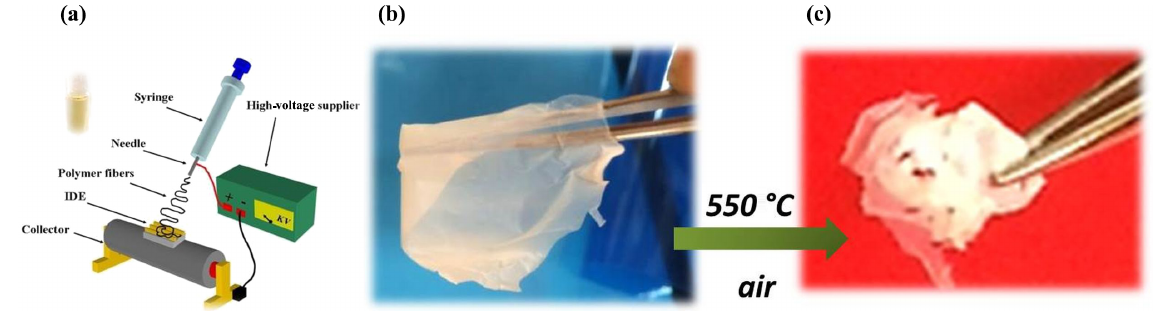
Figure 1. A sketch of an electrospinning setup comprised of a syringe and a grounded rotating cylinder collector where the samples are placed for coverage (a) ; a piece of TiiP/PVP nanofibrous fabric removed from the substrate after 1h of electrospinning deposition (b) ; a reddish purple aqueous solution of HAuCl 4 /PVP after UV light irradiation treatment and (c) a piece of the TiO 2 (anatase) nanofibrous fabric obtained after TiiP/PVP annealing.